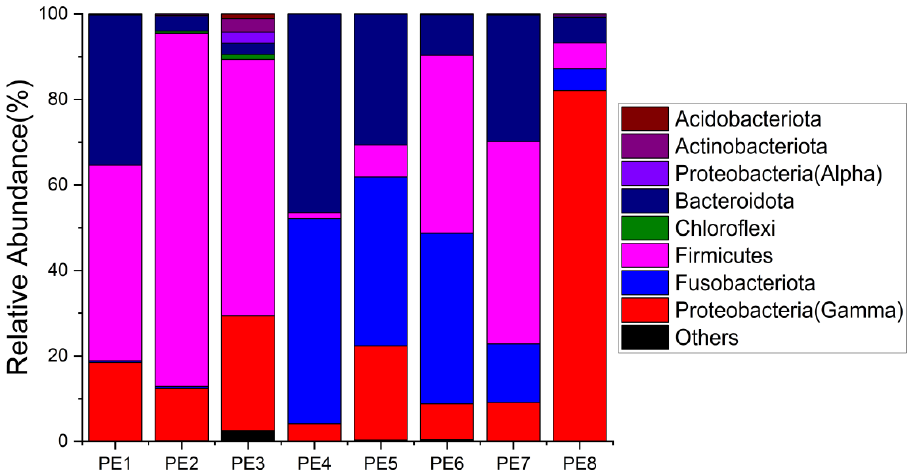
Figure 2. Gut microbial community members of eight stranded melon-headed whales (PE1-8) at the phylum level.